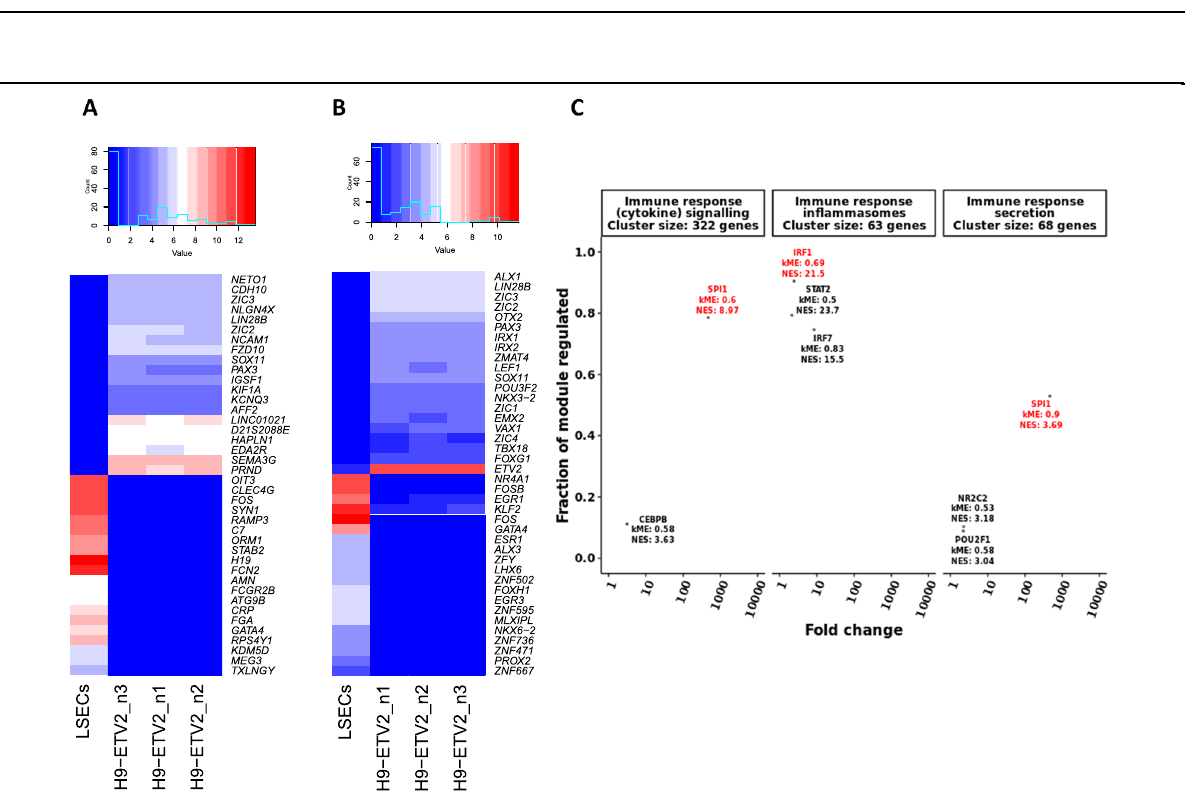
Fig. 5 CenTFinder analysis identi fi es SPI1 and IRF TFs as major LSEC regulators. A Heatmap of the top 20 most upregulated and downregulated genes in LSECs compared to ETV2-ECs. B Heatmap of the top 20 most upregulated and downregulated TFs in LSECs compared to ETV2-ECs. C CenTFinder core analysis results were combined. Each dot represents a TF that was differentially and higher expressed in LSECs compared to ETV2- ECs. In addition, only TFs with k ME > 0.5 and NES > 3 were considered. SPI1 was identi fi ed as the central TF in the immune response clusters related to cytokine signalling and secretion. IRF TFs were central to the immune response cluster related to in fl ammasomes. Top TFs are highlighted in